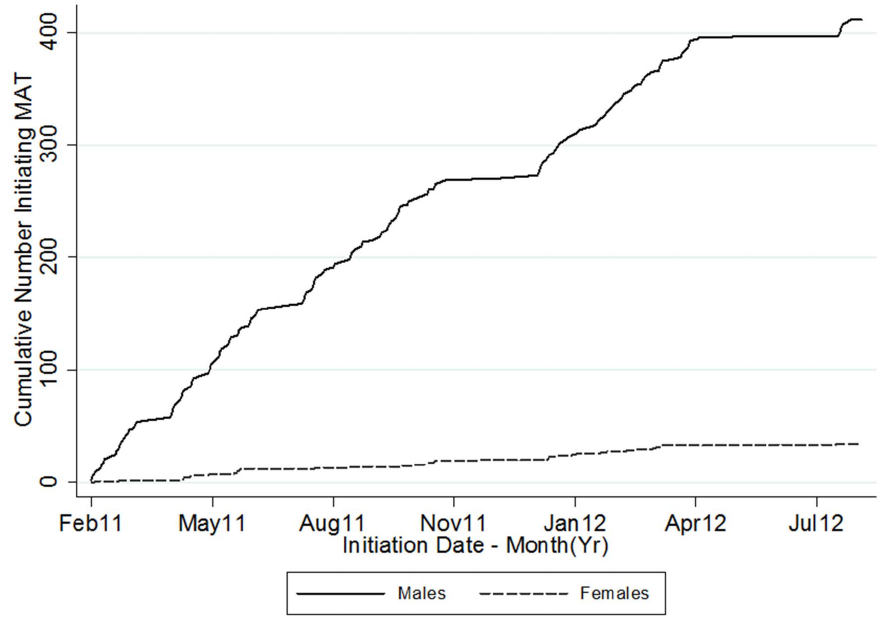
Figure 2. Cumulative Number of Male and Female PWIDs Initiating Medication Assisted Treatment.